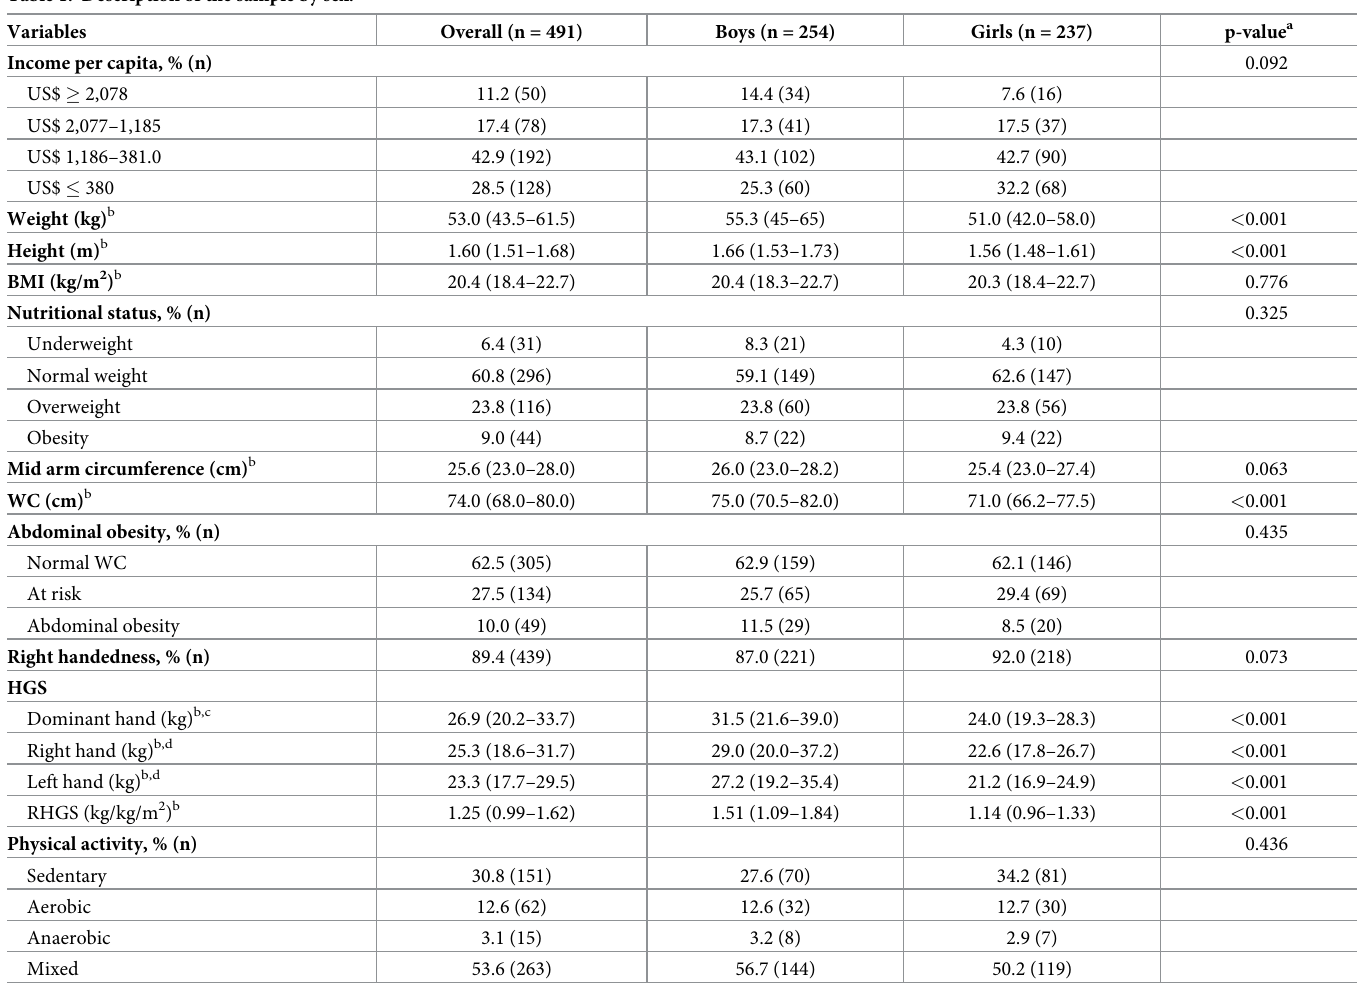
Table 1. Description of the sample by